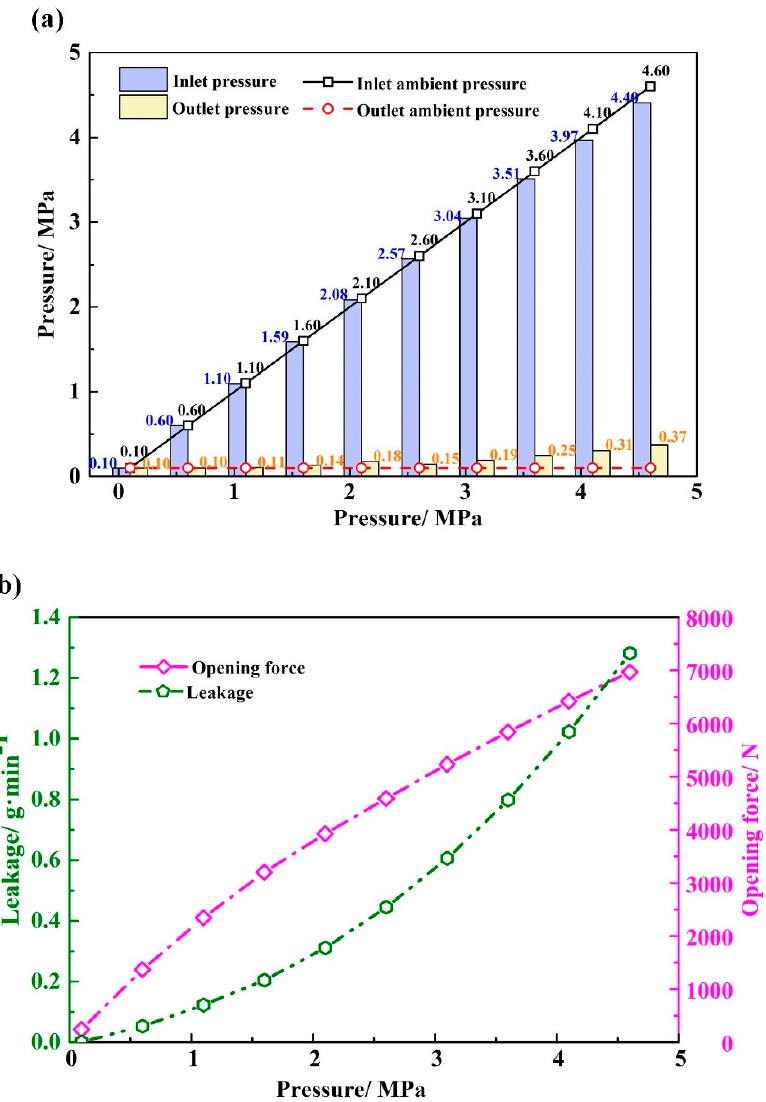
Figure 9. Relationship between the sealing performance and the sealing pressure. ( a ) Pressure boundaries between the seal rings; ( b ) Opening force and leakage. ( P out = 0.1 MPa, T in = 200 K, T out = 350 K, n = 50,000 rpm, h 0 = 3 μ m).